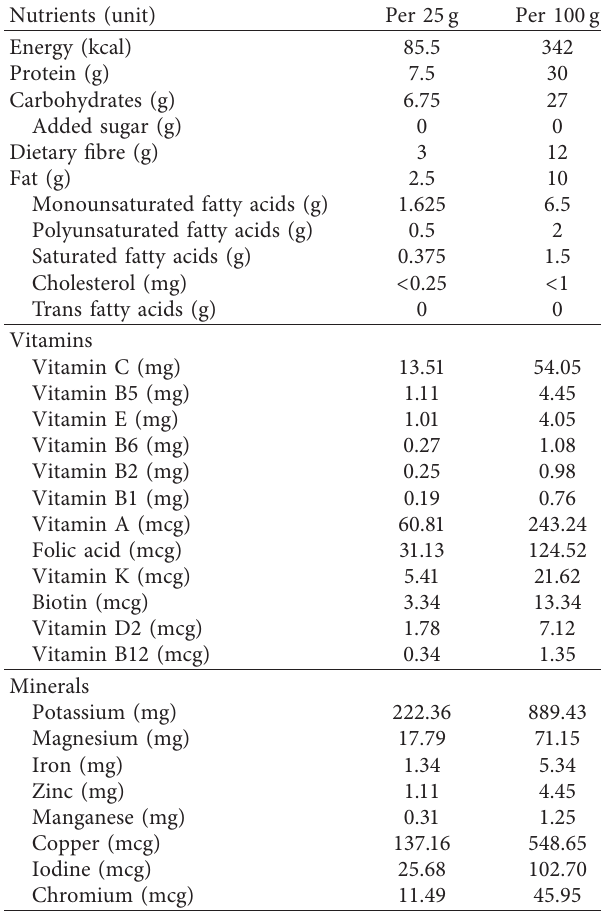
Table 1: Nutritional composition of the HPHF nutritional